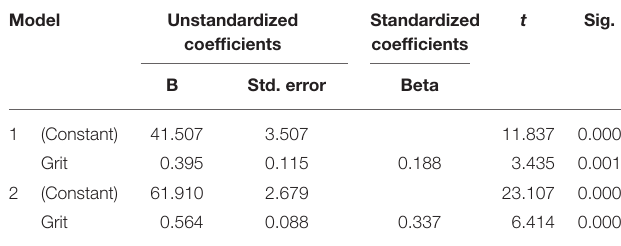
TABLE 5 | Regression results: